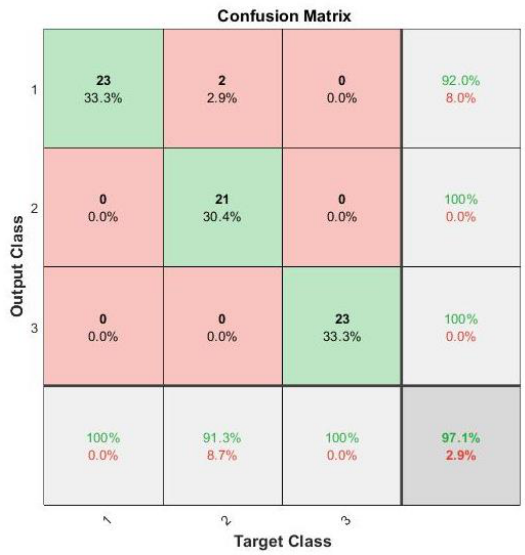
Figure 13. Confusion matrix of training with 97.10% accuracy.